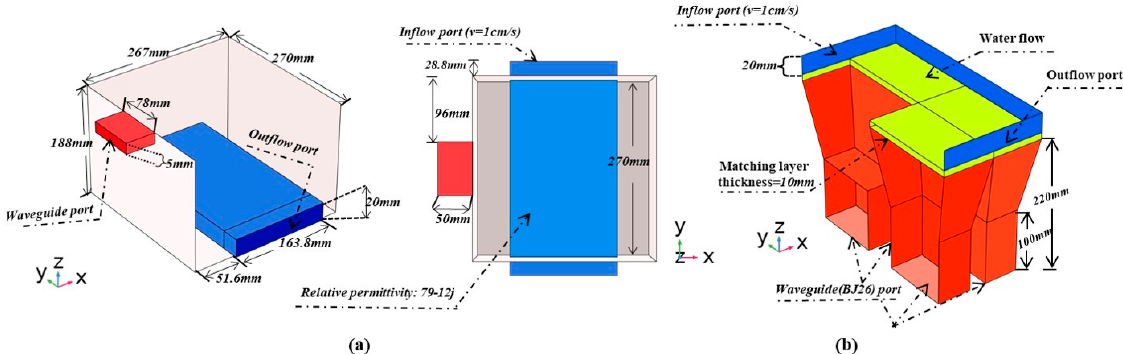
Figure 14. Plane size of the model; ( a ) multimode heating chamber; ( b ) horn antenna heating system.